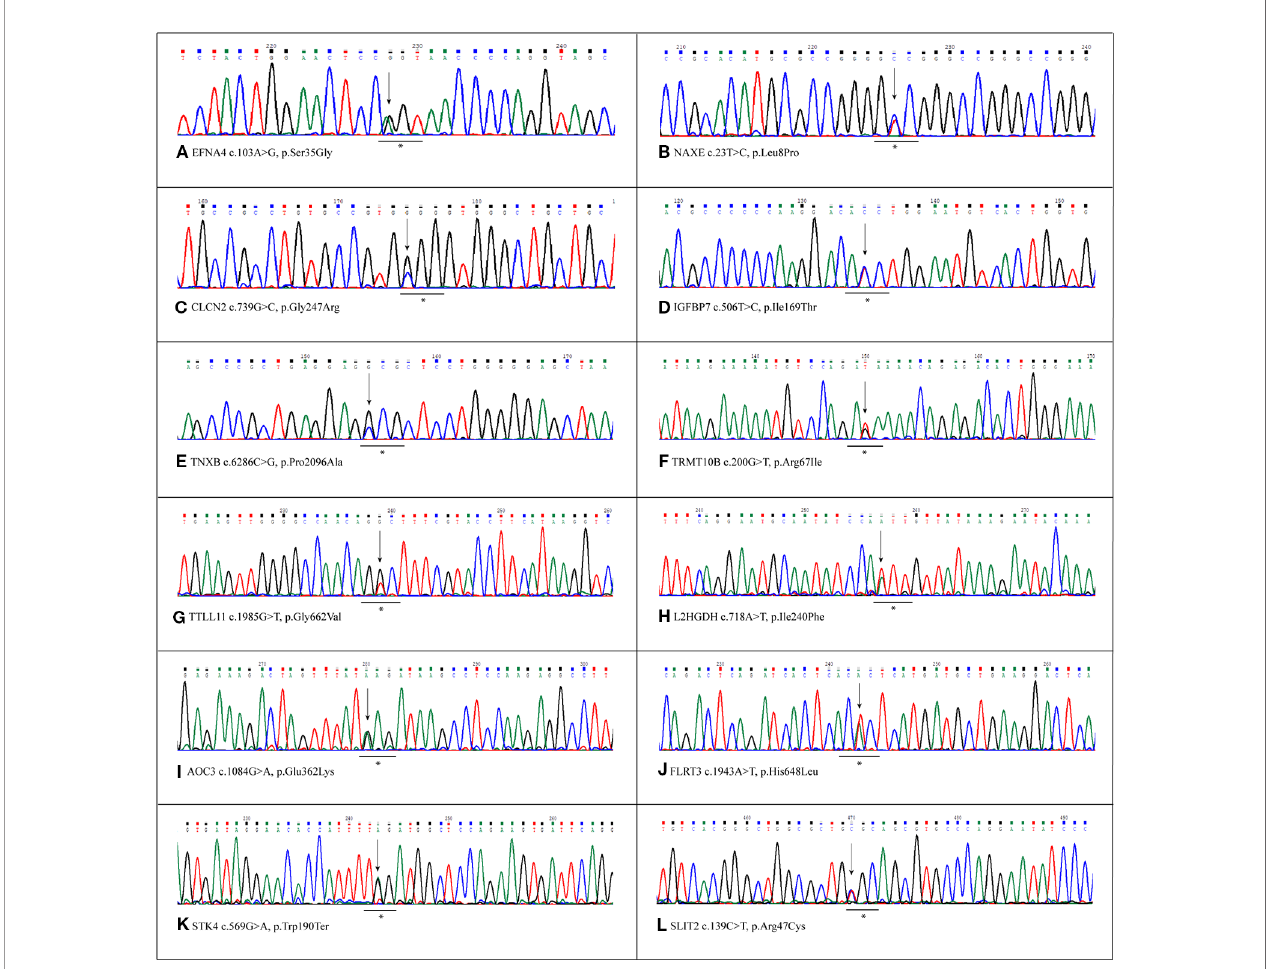
FIGURE 1 | Sanger validation of novel variants. Electropherograms show the novel variants detected by whole exome sequencing (WES) and con fi rmed by Sanger sequencing. Each panel refers to the single variant described at the bottom of the same panel. The underlined asterisked triplets indicate the codons affected by mutations. All variants were detected in heterozygous condition. (A) Variant detected in EFNA4 gene, c.103A>G, p.Ser35Gly. (B) Variant detected in NAXe gene, c.23T>C, p.Leu8Pro. (C) Variant detected in CLCN2 gene, c.739C>G,p.Gly247Arg. (D) Variant detected in IGFBP7 gene, c.506T>C, p.Ile169Thr. (E) Variant detected in TNXB gene, c.286C>G, p.Pro2096Ala (F) Variant detected in TRMT10B gene, c.200G>T,p.Arg67Ile. (G) Variant detected in TTLL11 gene, c.1985G>T, p.Gly662Val. (H) Variant detected in L2HGDH gene, c.718A>T, p.Ile240Phe. (I) Variant detected in AOC3 gene, c.1084G>A, p.Glu362Lys (J) Variant detected in FLRT3 gene, c.1943A>T, p.His648Leu. (K) Variant detected in STK4 gene, c.569G>A, p.Trp190Ter. (L) Variant detected in SLIT2 gene,